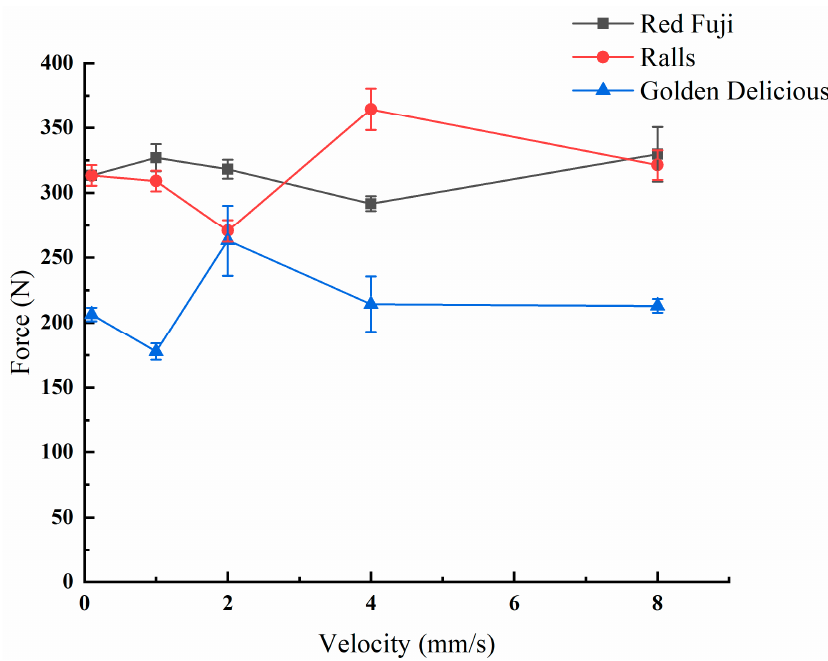
Figure 7. Peak force–speed relationships of different apple varieties, at a distance of 6 mm.